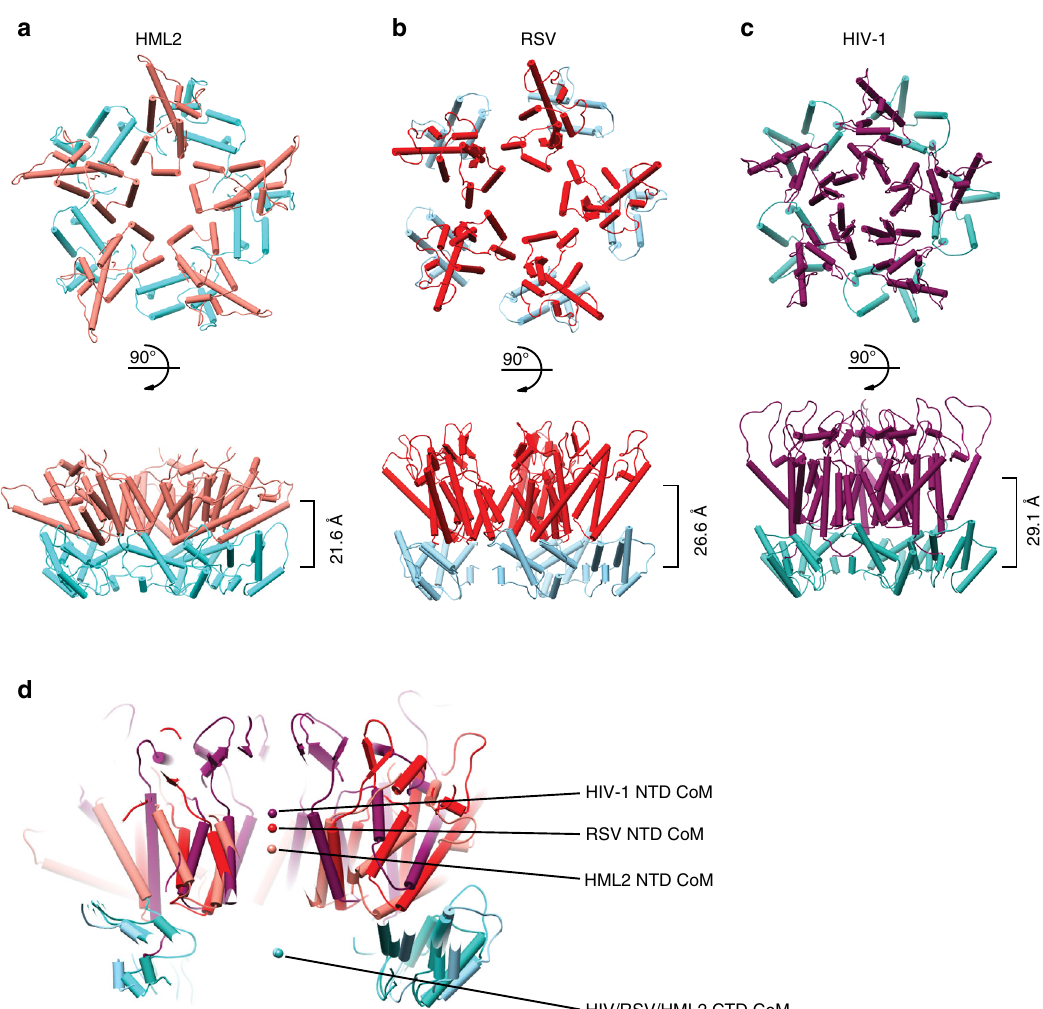
Fig. 3 Comparison of HIV-1, RSV and HML2 CA pentamers. a – c Top and side view cartoon representations of CA pentamers with α -helices shown as cylinders, from a HML2 CA rec , b RSV (built from PDB: 1EM9 and 3G1I docked into EMD 5772) and c HIV-1 (PDB: 5MCY). NTDs are coloured pink, red and purple and CTDs are coloured light cyan, light blue and cyan for HML2, RSV and HIV-1, respectively. Pentamers are aligned with respect to their CTDs. In the lower panels, the distance between the centre of mass (CoM) for each NTD and CTD ring is shown on the right. d Central section through CA pentamers aligned with respect to CTDs. The CoM for NTD and CTD rings is represented by the spheres, colour coded as in a – c and shows the coincident CoM for CTDs and the difference in CTD – NTD vertical displacement for each